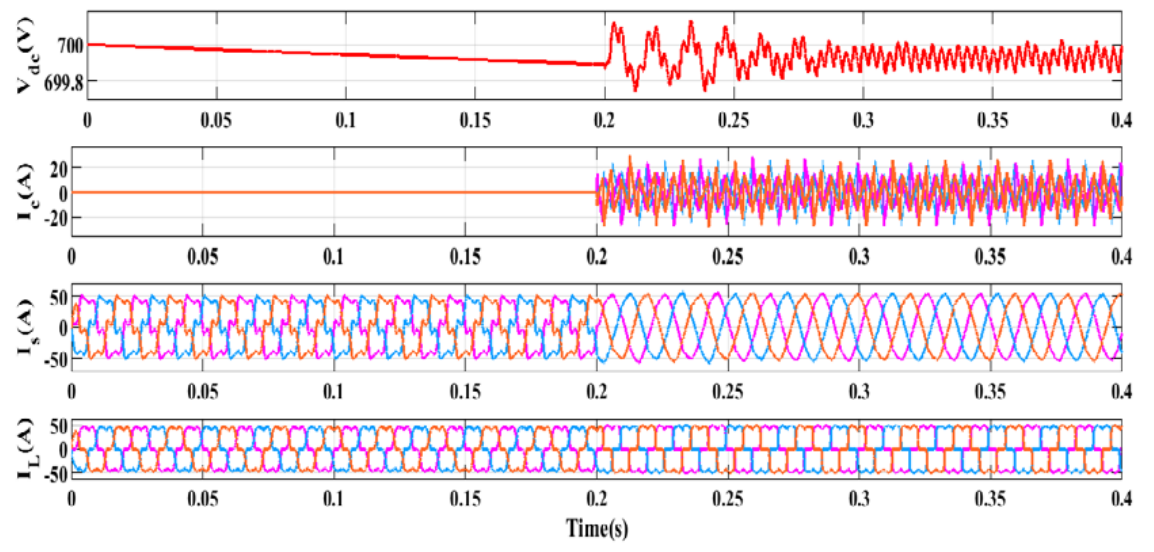
-based DSTATCOM with electric arc furnace-based non-linear 𝜽𝜽